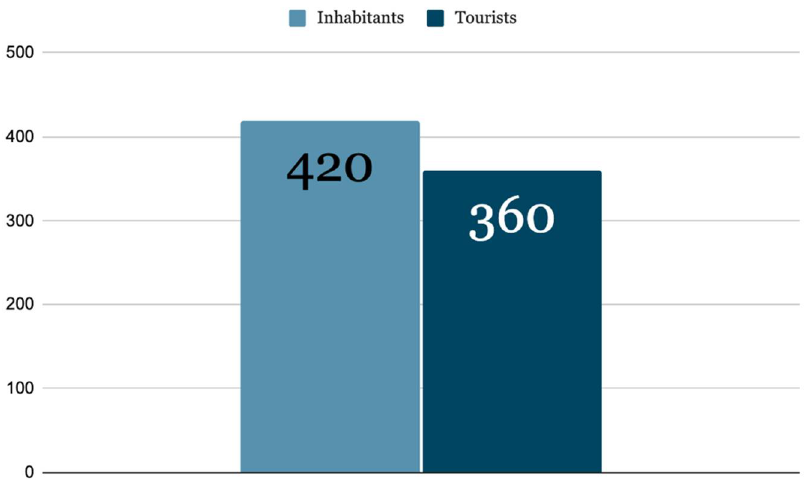
Figure 4. Distribution of surveys . Source: own elaboration.